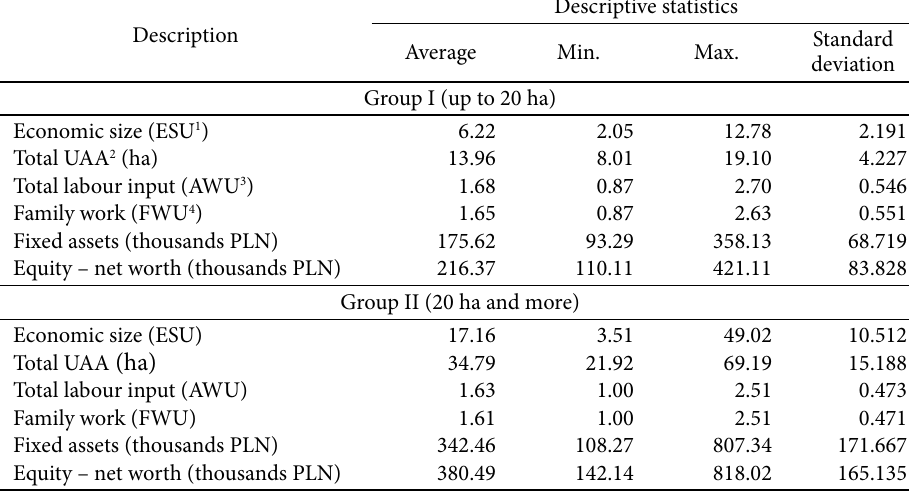
Table 2 . Characteristic of organic farms in the years 2008–2012